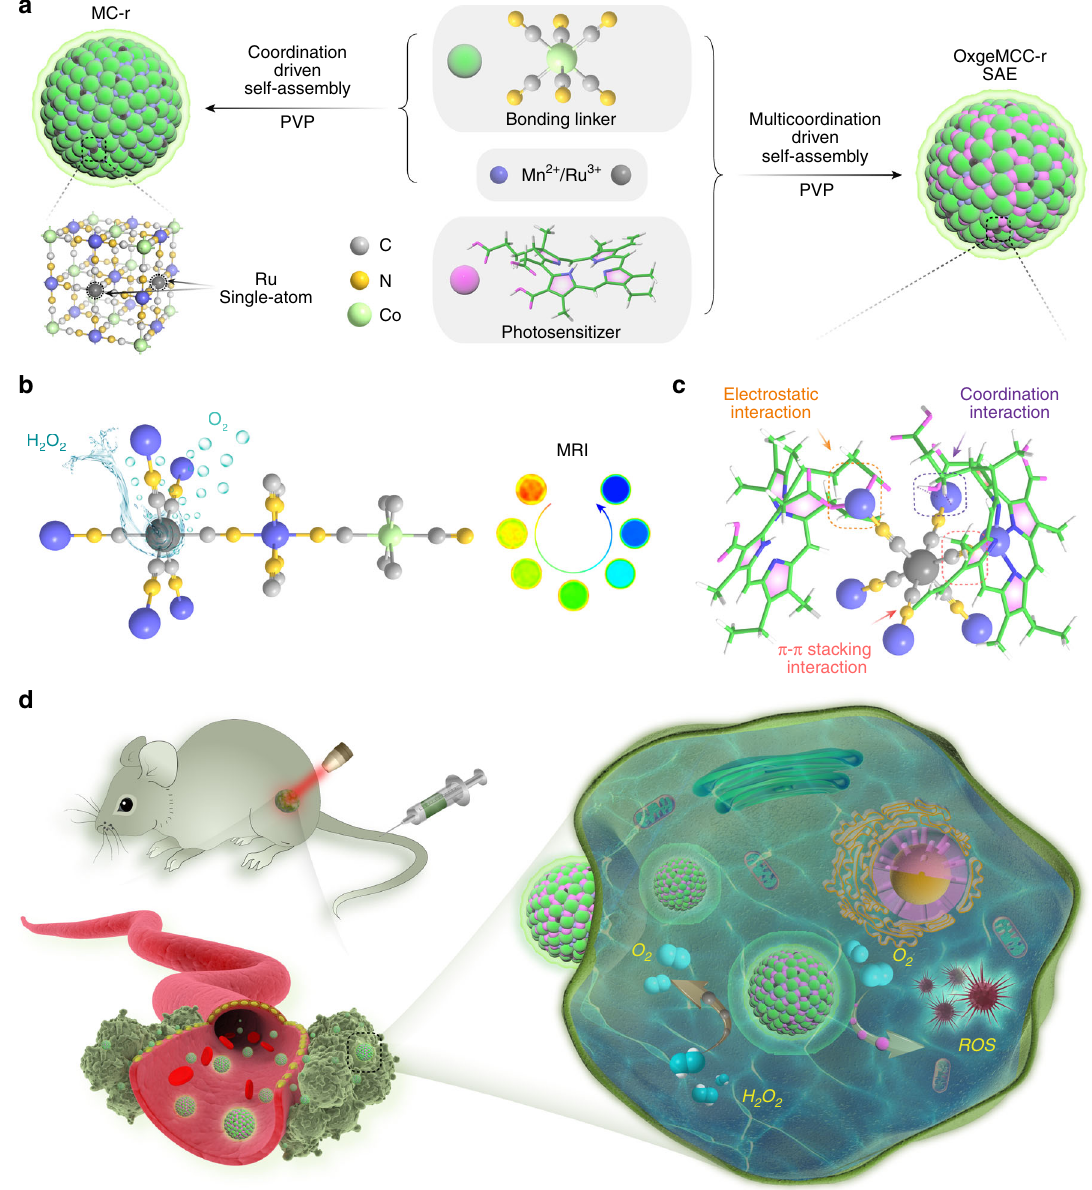
Fig. 1 Design of OxgeMCC-r nanozyme with single-atom Ru for cancer treatment. a Schematic illustration of OxgeMCC-r. OxgeMCC-r consists of catalytically active single-atom Ru site anchored in MCC with outer PVP protection layer. b Partial molecular structure of OxgeMCC-r with active single- atom Ru site serving as catalase-like nanozyme for oxygen generation. c Multicomponent coordination interactions within the OxgeMCC-r SAE. d Scheme of continuously catalytic oxygen generation and ROS production for enhanced PDT of cancer by OxgeMCC-r